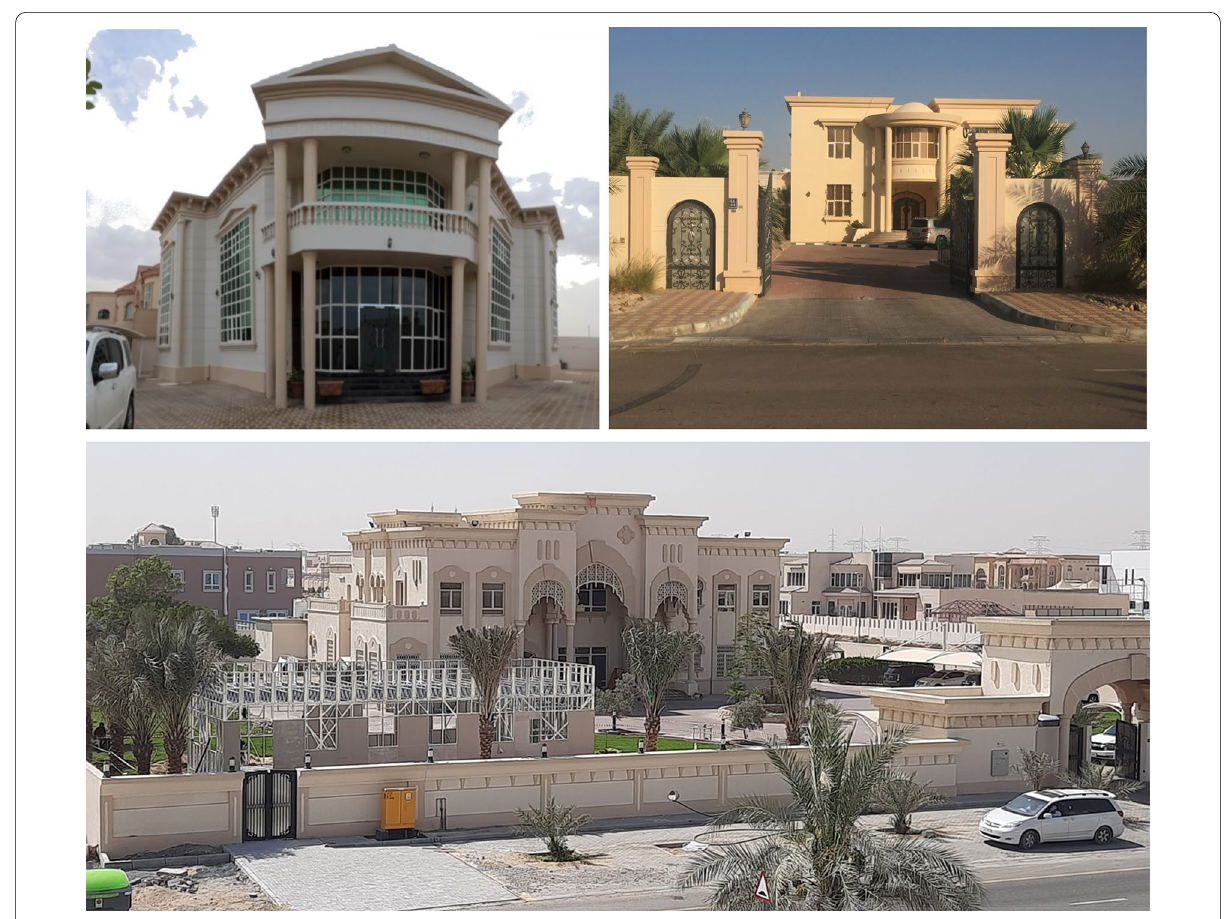
Fig. 7 On top, recently built consolidated Emirati villas—iconic, formal, reductive and seemingly complete, where elevation is the frontispiece. On bottom: Under construction accretion of second external majlish inside villa compound taking place in 2021, long after the core villa completion. Note the separate entry from the outdoor parking for the new majlis . Photos: Authors 2008–2016 Abu Dhabi (top); 2021 Sharjah